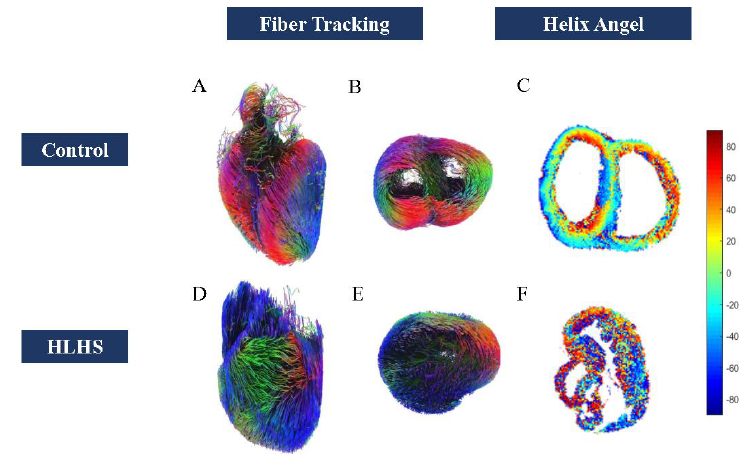
Figure 4. ( A , B ) Whole heart fiber tracking in a normal fetus. ( A ) from ventral view, ( B ) from apical view. ( D , E ) the whole heart fiber tracking in an HLHS fetus D from ventral view and ( E ) from apical view. ( C ) HA map in normal fetus. ( F ) HA map in HLHS fetus.